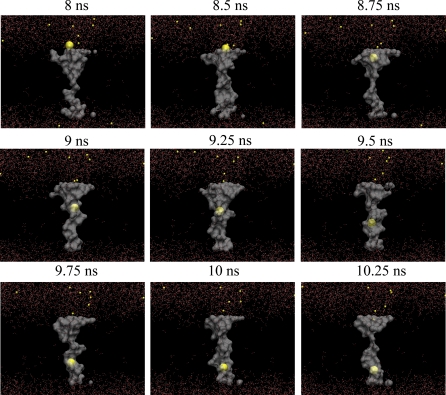
Successive Snapshots from the MD Simulation Show Translocation of a Single Cation through the nAChR Channel (Applied Trans-Membrane Potential, −100 mV)Water molecules inside the nAChR channel are shown in surface representation, with the permeating cation in VDW representation. Water molecules outside the channel are shown in line representation, and other cations are shown as small yellow spheres. The protein and lipids are omitted.